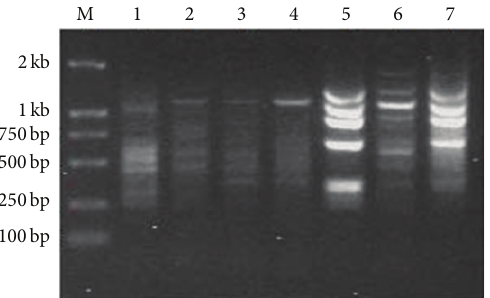
Figure 1: Detection of the secondary PCR products of (1) forward- subtractedexperimentalcDNAwhichwashighlyexpressedinMRT; (2) unsubtracted total cDNA from MRT; (3) reverse-subtracted experimental cDNA which was highly expressed in the shrimp control tissue; (4) unsubtracted total cDNA from the shrimp control tissue; (5) subtracted control skeletal muscle cDNA from SSH kit; and (6) unsubtracted tester control for the control subtraction from SSH kit; and (7) PCR control-subtracted cDNA from SHH kit.